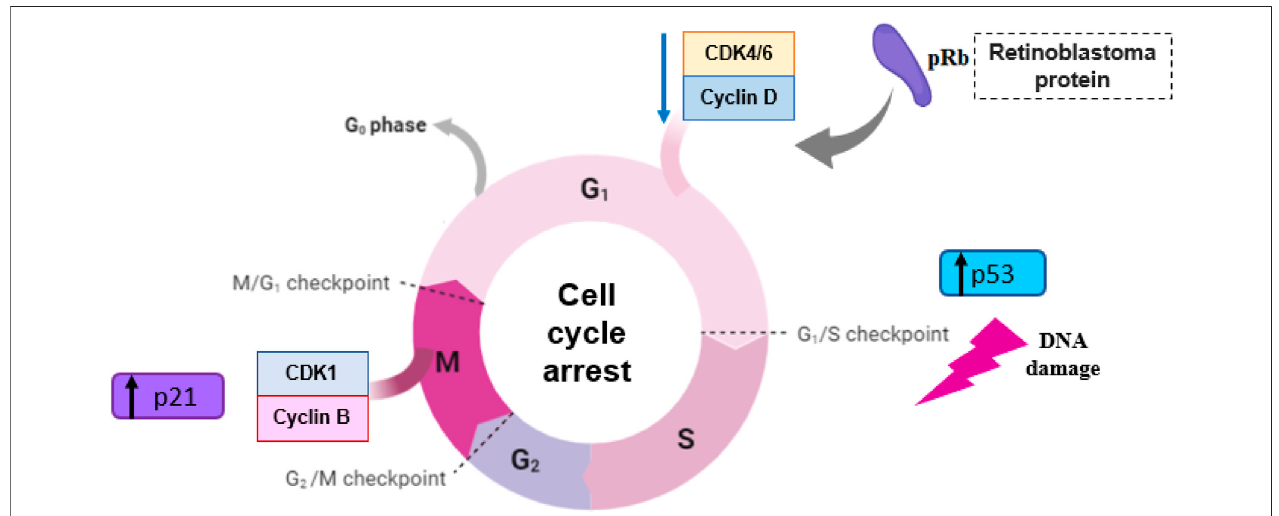
FIGURE 5 | Cell cycle involvement in cancer treatment with carvacrol and